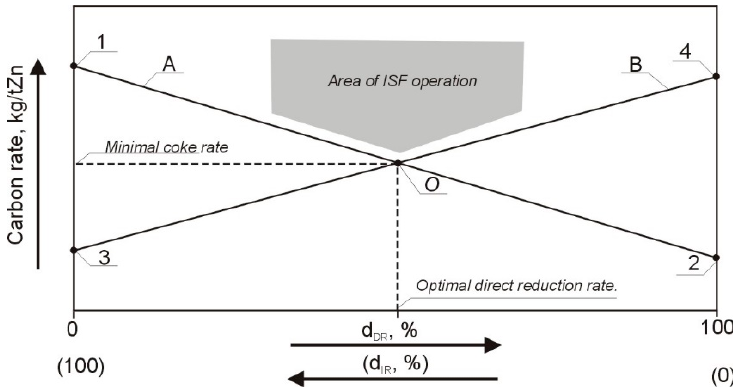
Figure 6. Carbon rate–ZnO reduction ratio diagram.